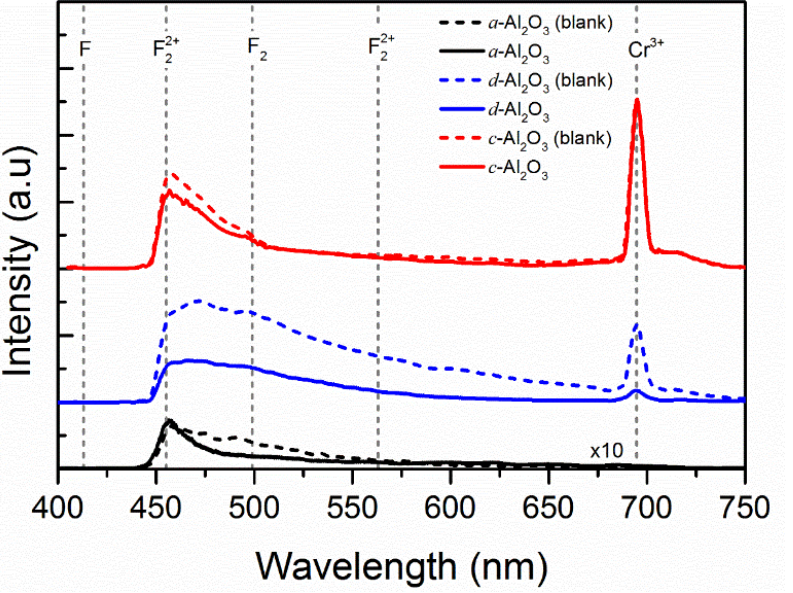
Figure 4. Photoluminescence spectra of α -Al 2 O 3 (amorphous, solid black line), d -Al 2 O 3 (disordered, solid blue line), and c -Al 2 O 3 (crystalline, solid red line) samples implanted with Si ions and annealed at 1200 °C (with a vertical offset and magnified where indicated for clarity). The samples before implantation and annealing are labelled “blank”.